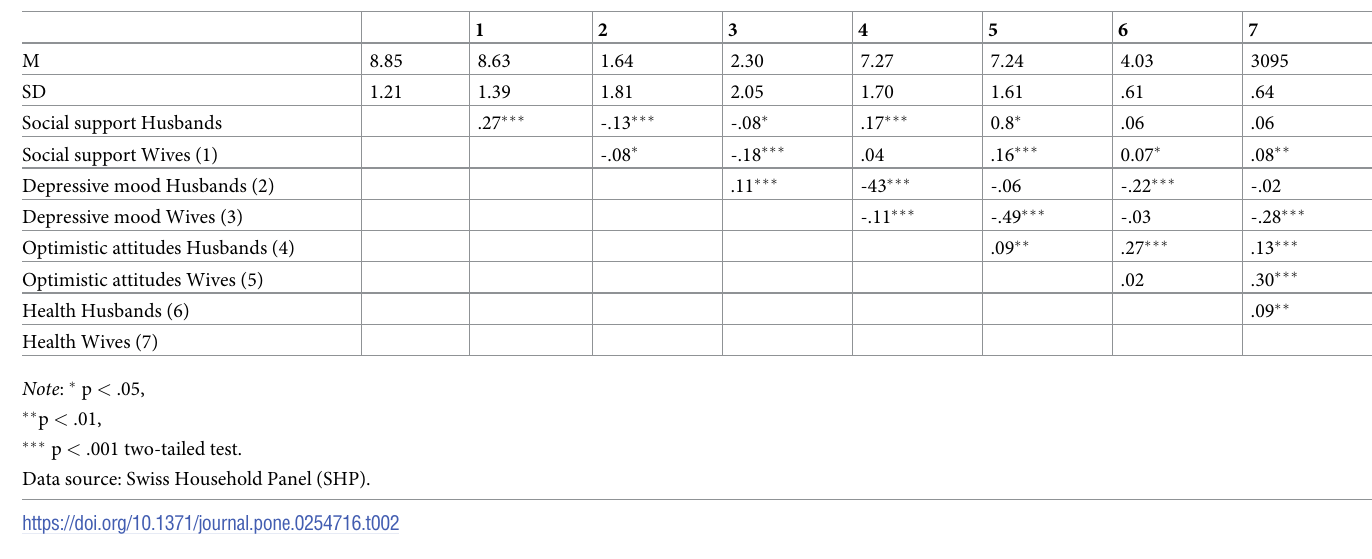
Table 2. Pearson’s bivariate